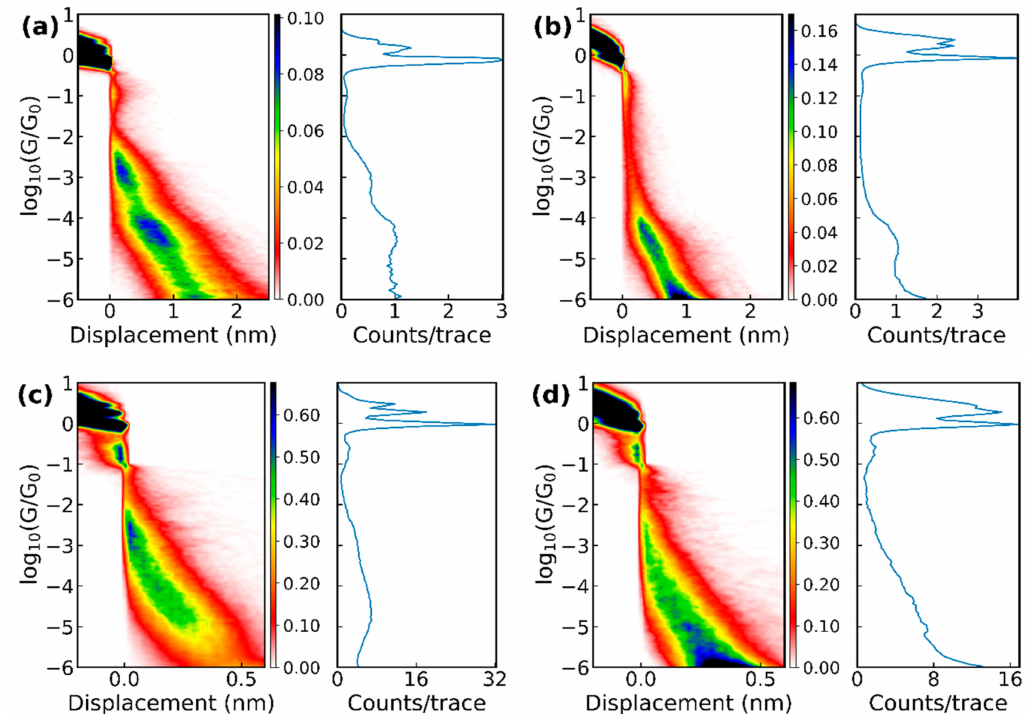
Figure 3. 1D and 2D histograms of the raw data of ( a ) 6000 breaking traces of methionine and ( b ) 4000 breaking traces of cysteine measured with the MCBJ setup, as well as ( c ) 5745 traces of methionine and ( d ) 3584 traces of cysteine at pH = 7 measured with the